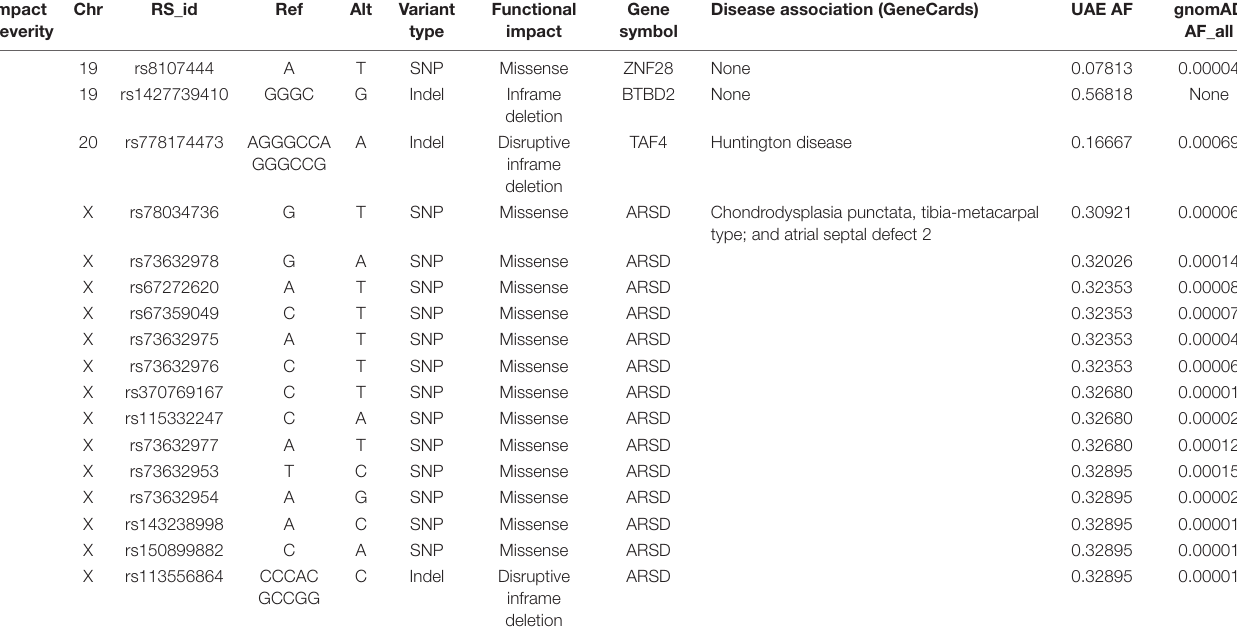
8,845 inversions, 11,818 insertions, 27,620 duplications, 40,582 deletions, and 48,902 transitions ( Supplementary Table S2 ) were identified. The AF distribution is shown in Supplementary Figure S5 . A genome overview of the short and SVs sets using Circos (Krzywinski et al., 2009) is shown in Figure 4 . allows for the identification of chromosomal positions with